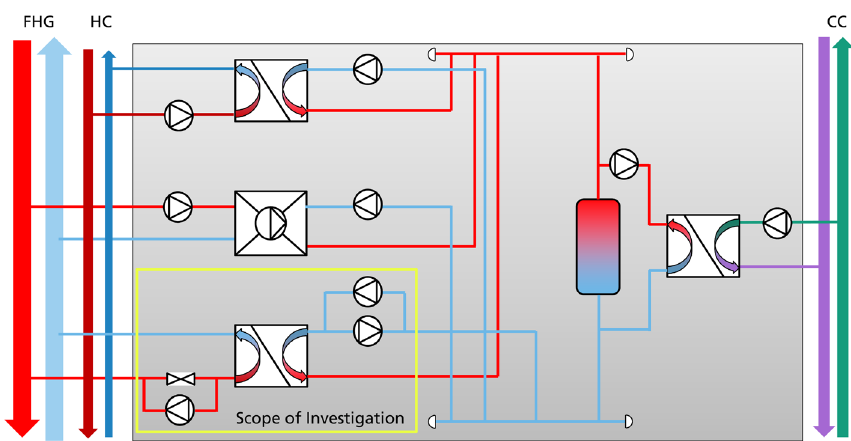
Fig. 2 Schematic representation of a HIL unit and scope of this investigation [own